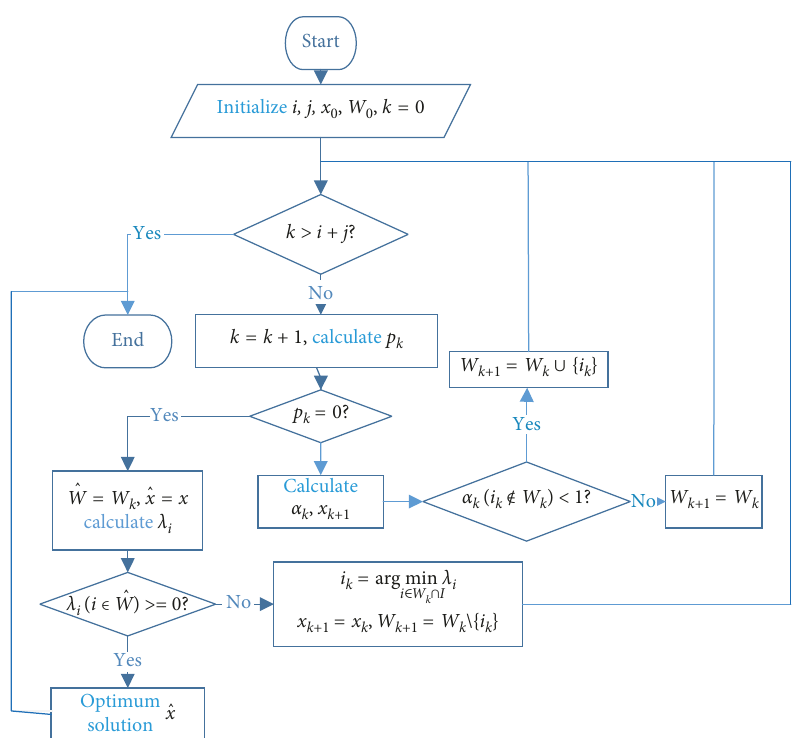
Figure 11: The active set method